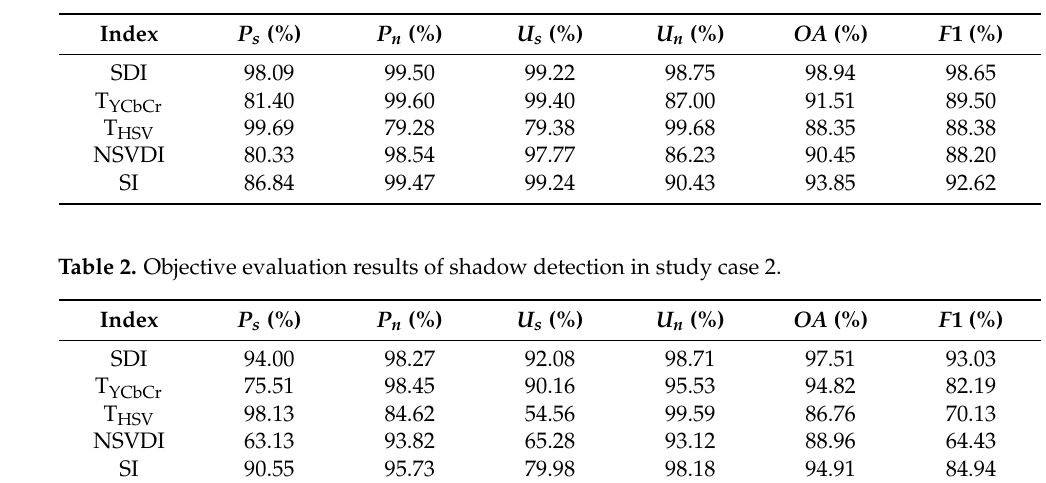
Figure 6. The detection results of different methods applied to study case 2: ( a ) original image shown with R, G, B bands; ( b ) SDI; ( c ) T YCbCr ; ( d ) T HSV ; ( e ) NSVDI; ( f ) SI. Table 1. Objective evaluation results of shadow detection in study case 1.